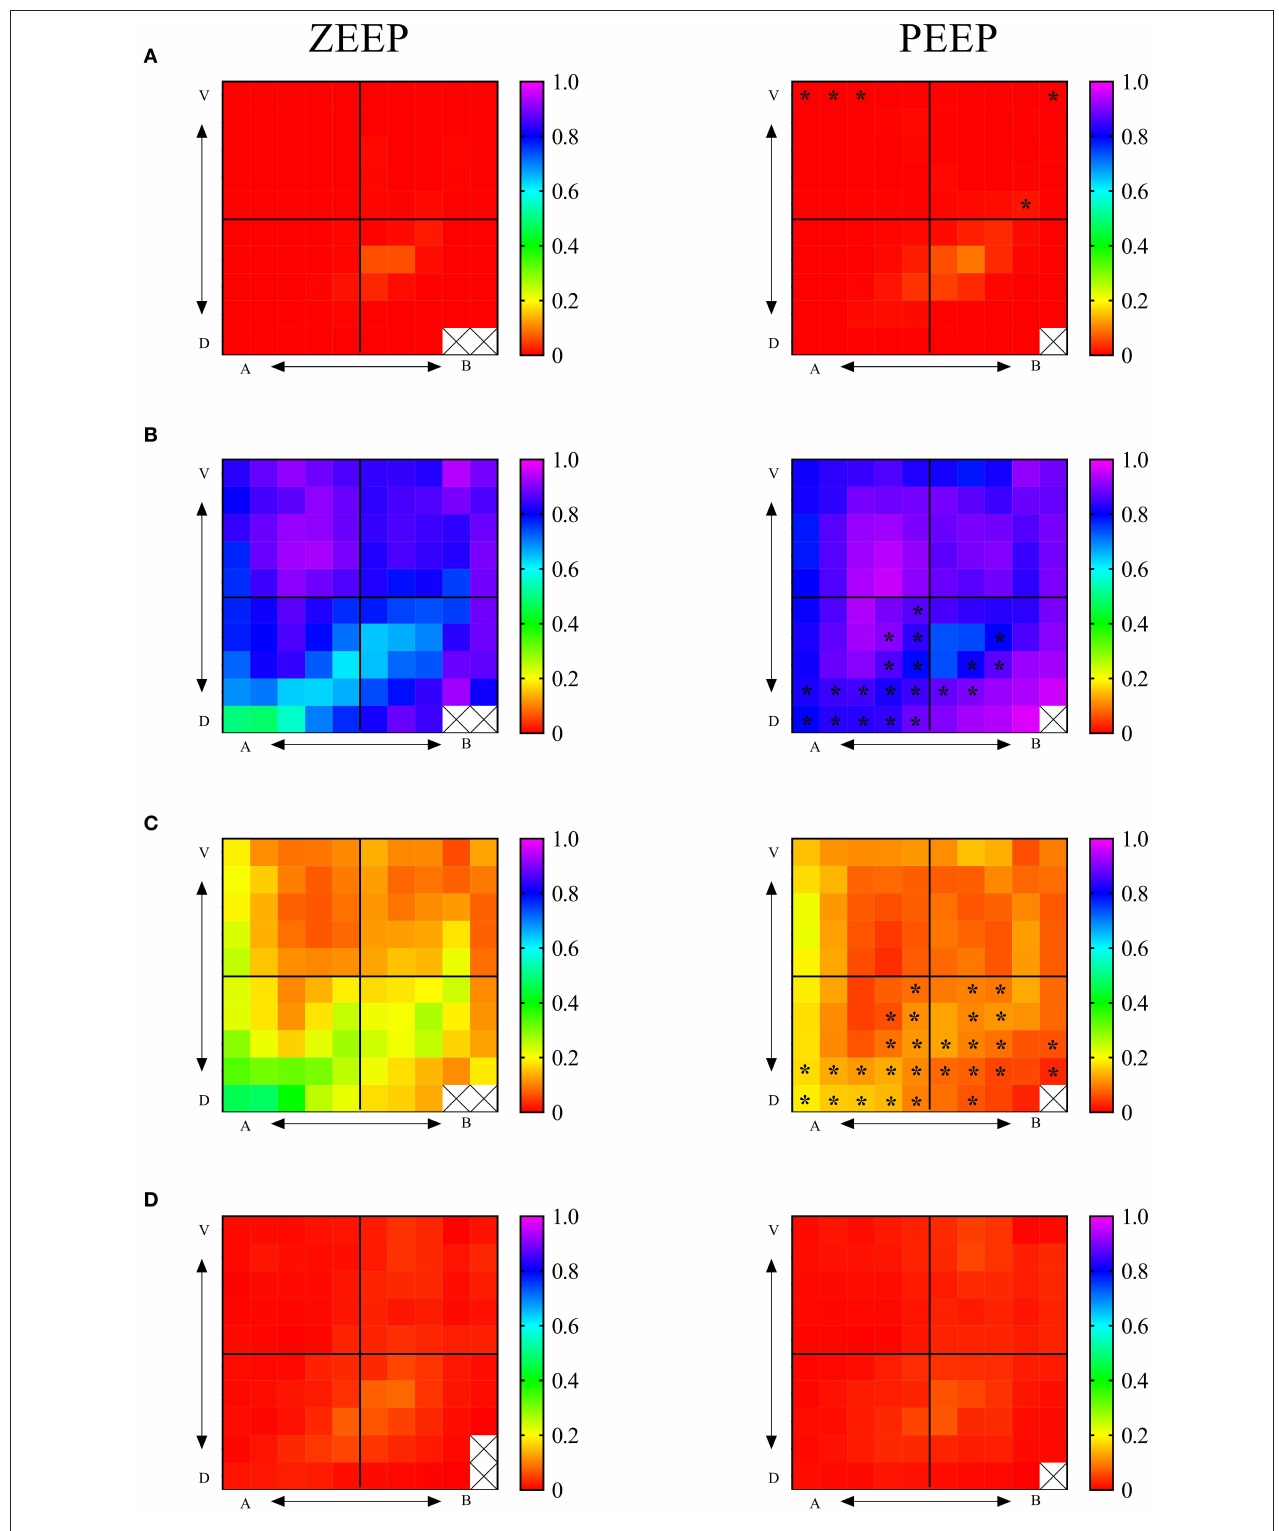
FIGURE 3 | Regional 2D maps of fractional lung aeration during ZEEP and PEEP per ROI. (A) Fraction of hyperaerated tissue, (B) fraction of normoaerated tissue, (C) fraction of poorly aerated tissue, (D) fraction of nonaerated tissue. V, ventral; D, dorsal; A, apical; B, basal. Color palettes represent the range of fractional aeration for each 2D map, with 0 corresponding to 0% and 1-100% of the total lung tissue. * p < 0.05 compared with the same topographic ROI during